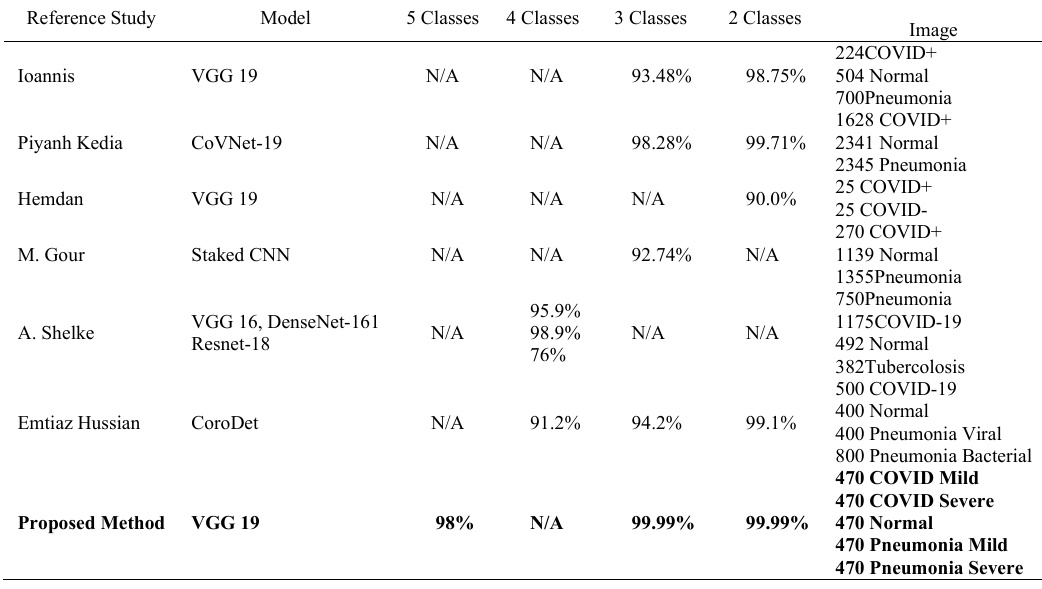
TABLE 8 PERFORMANCES OF FIVE - CLASS , THREE - CLASS AND TWO -